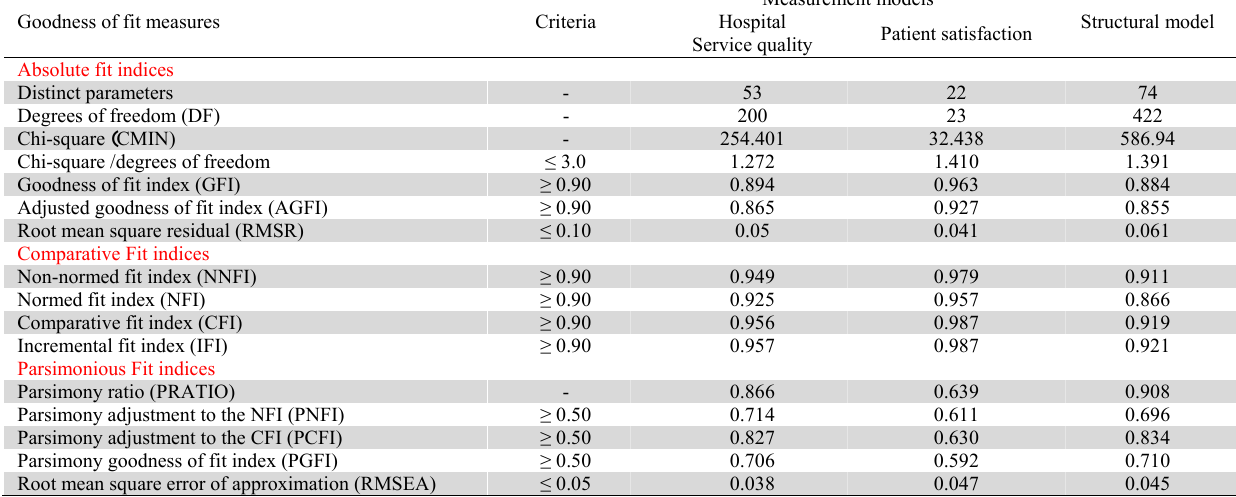
Goodness of fit indices for two measurement models and structural model Goodness of fit measures